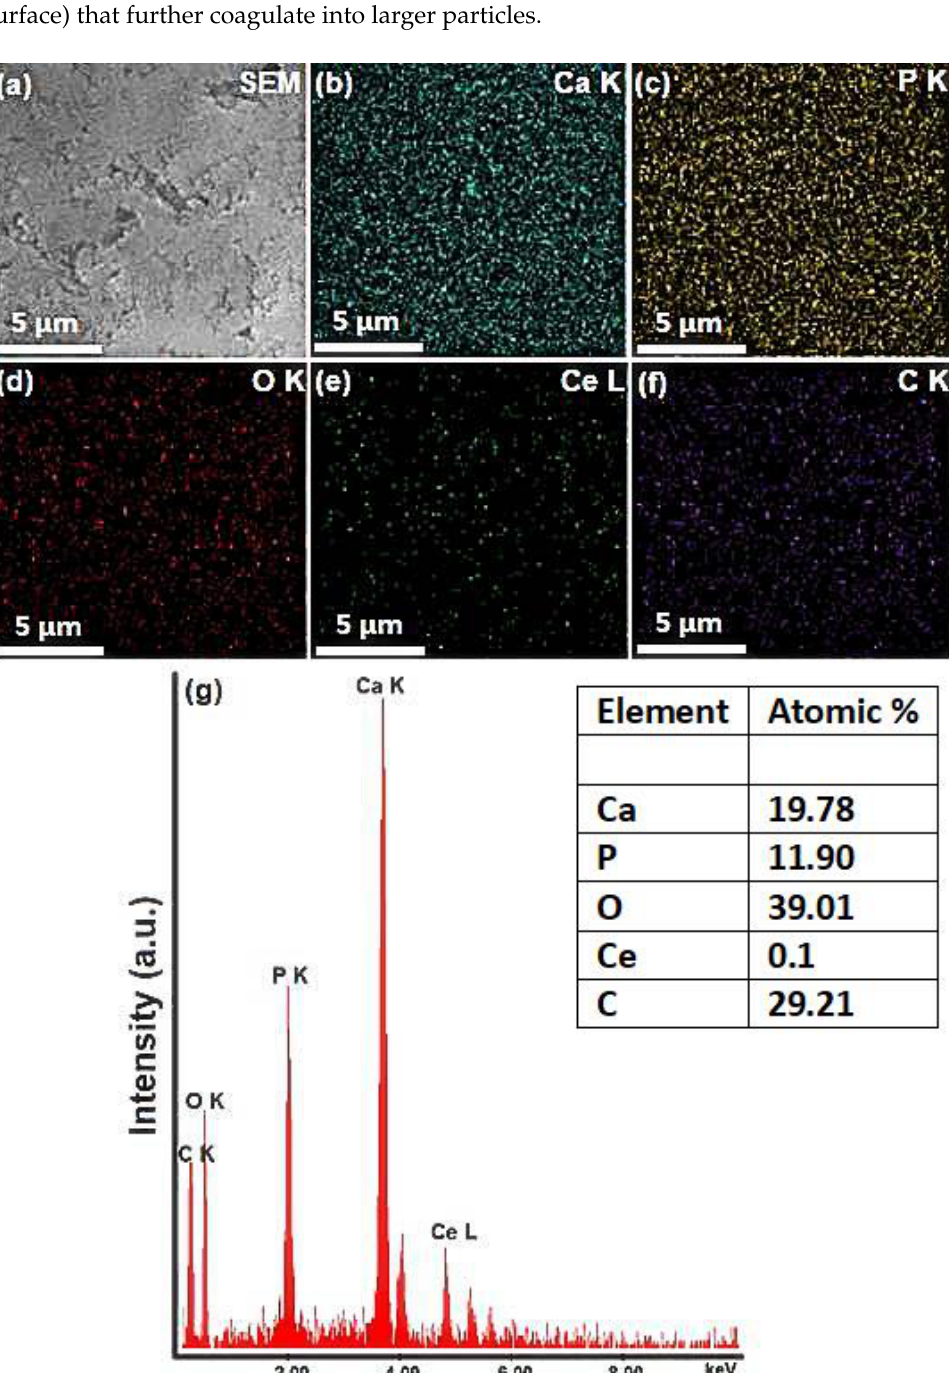
Figure 4. SEM image ( a ), EDS elemental mapping of the constituent elements of 10CeHAp-D com- posite target ( b – f ) and EDS spectrum of 10CeHAp-D composite target ( g ).